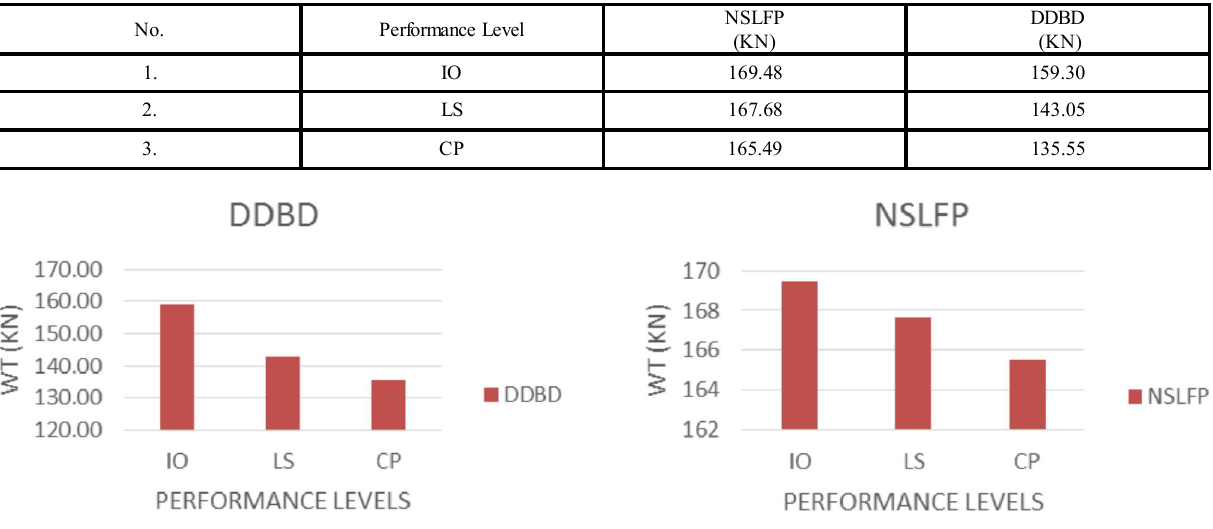
FIG. 2. OPTIMAL STRUCTURAL WEIGHTS AGAINST DIFFERENT PERFORMANCE